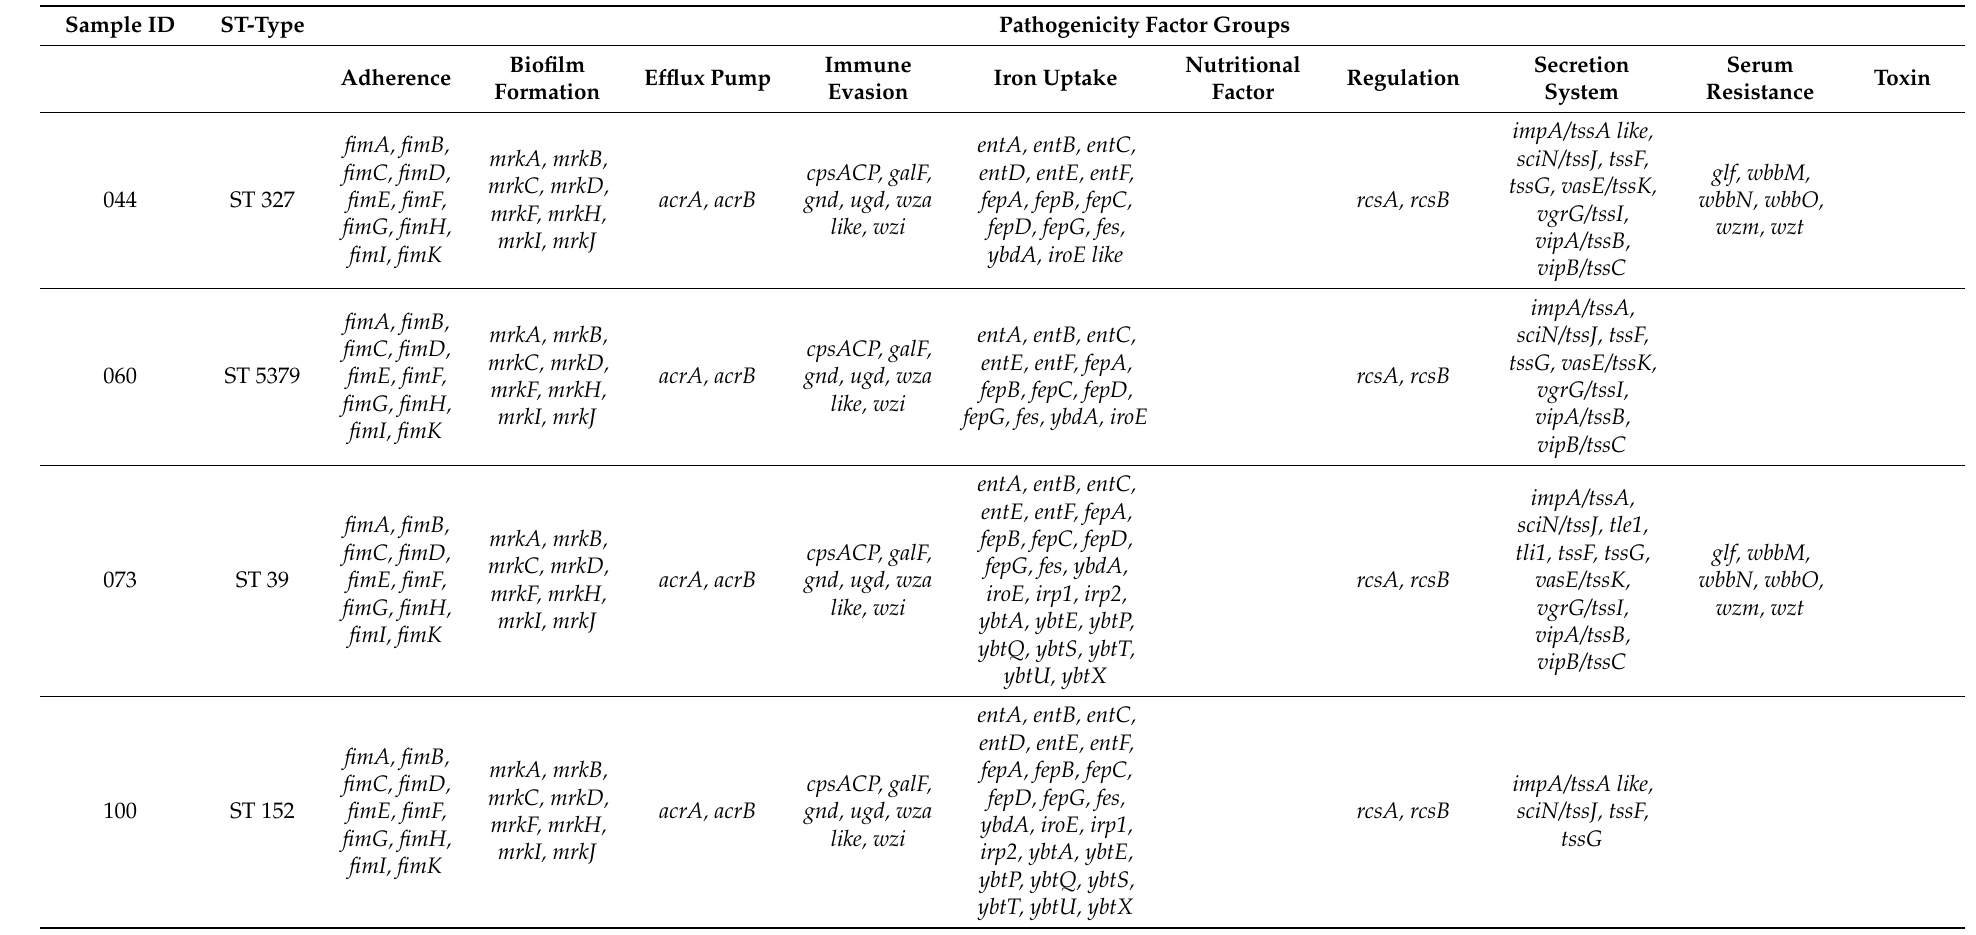
Table A10. Analysis of virulence determinants, ordered by strain and MLST type, of the assessed K. pneumoniae isolates. ST = Sequence